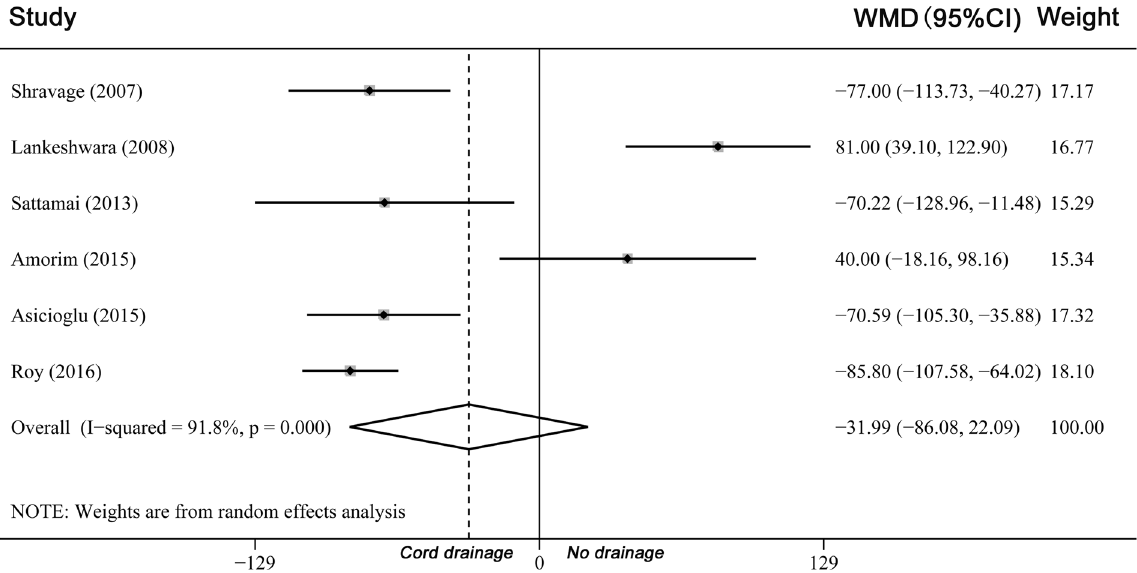
Figure 4. Comparison of cord drainage versus no drainage (all). Outcome: Average blood